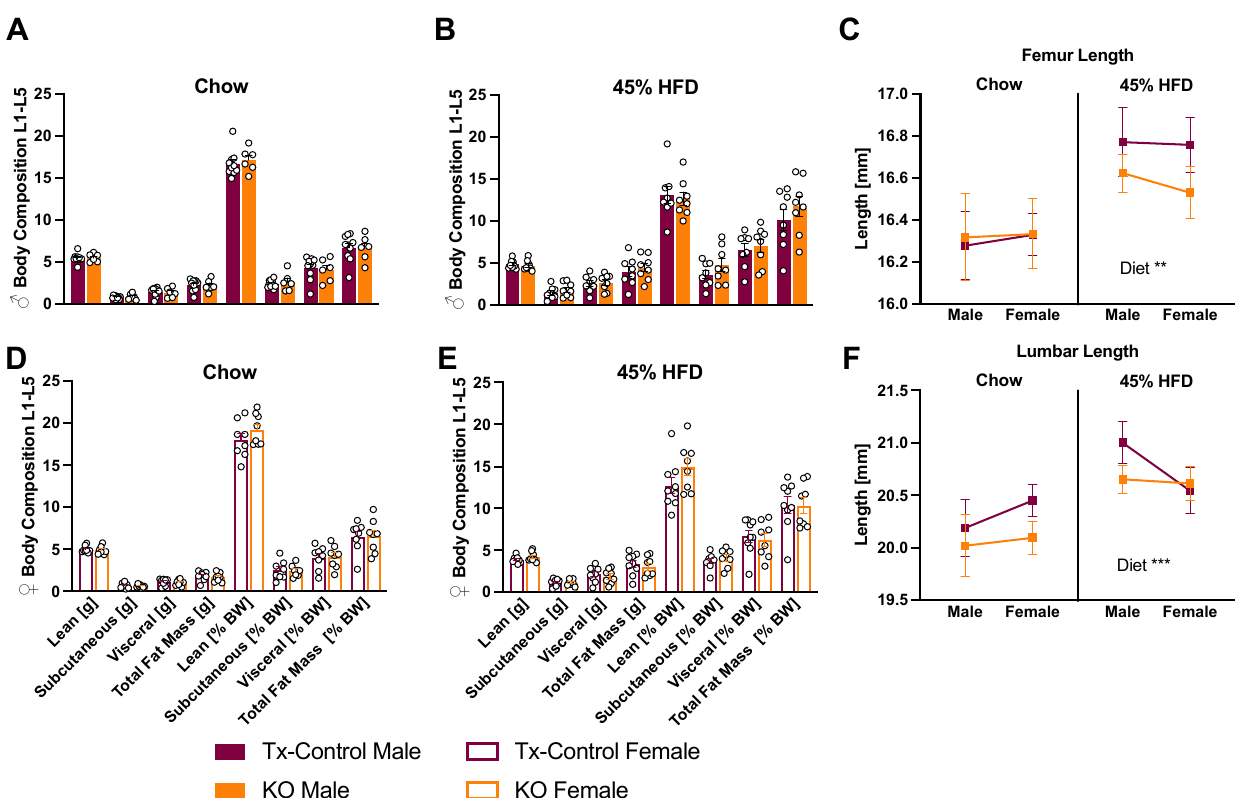
Figure 3. CTR depletion in microglia does not alter body composition or skeletal growth. Lean and fat mass were quantified post mortem in knockout mice and tamoxifen controls. Subcutaneous and visceral fat were quantified separately, but no significant difference for males ( A , B ) or females ( D , E ) was detected. 45% HFD led to more body fat ( B , E ) and to an increase in skeletal growth independent of genotype or sex ( C , F ); Skeletal length showed a diet effect after mixed-effects analysis. Values are displayed as mean ± SEM; n = 6–10 per group. Summary statistics after three-way ANOVA (Diet, sex, and genotype) detected a diet effects ( C , F ) *** p < 0.01 ** p <